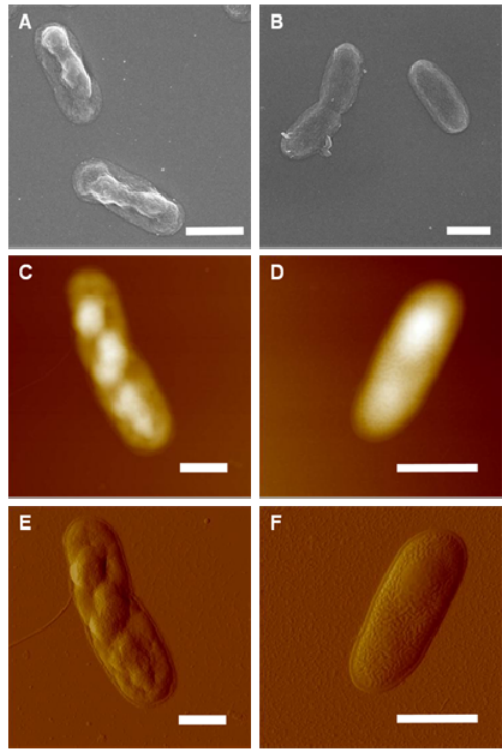
Figure 6. E. coli cells that over-expressed HCcp3 and control cells without HCcp3 expression . ( A , C , E ) Cells that over-expressed HCcp3; ( B , D , F ) Control cells; ( A , B ) Scanning electron microscopy images; ( C – F ) Atomic force microscopy images. Scale bar 1 µm.